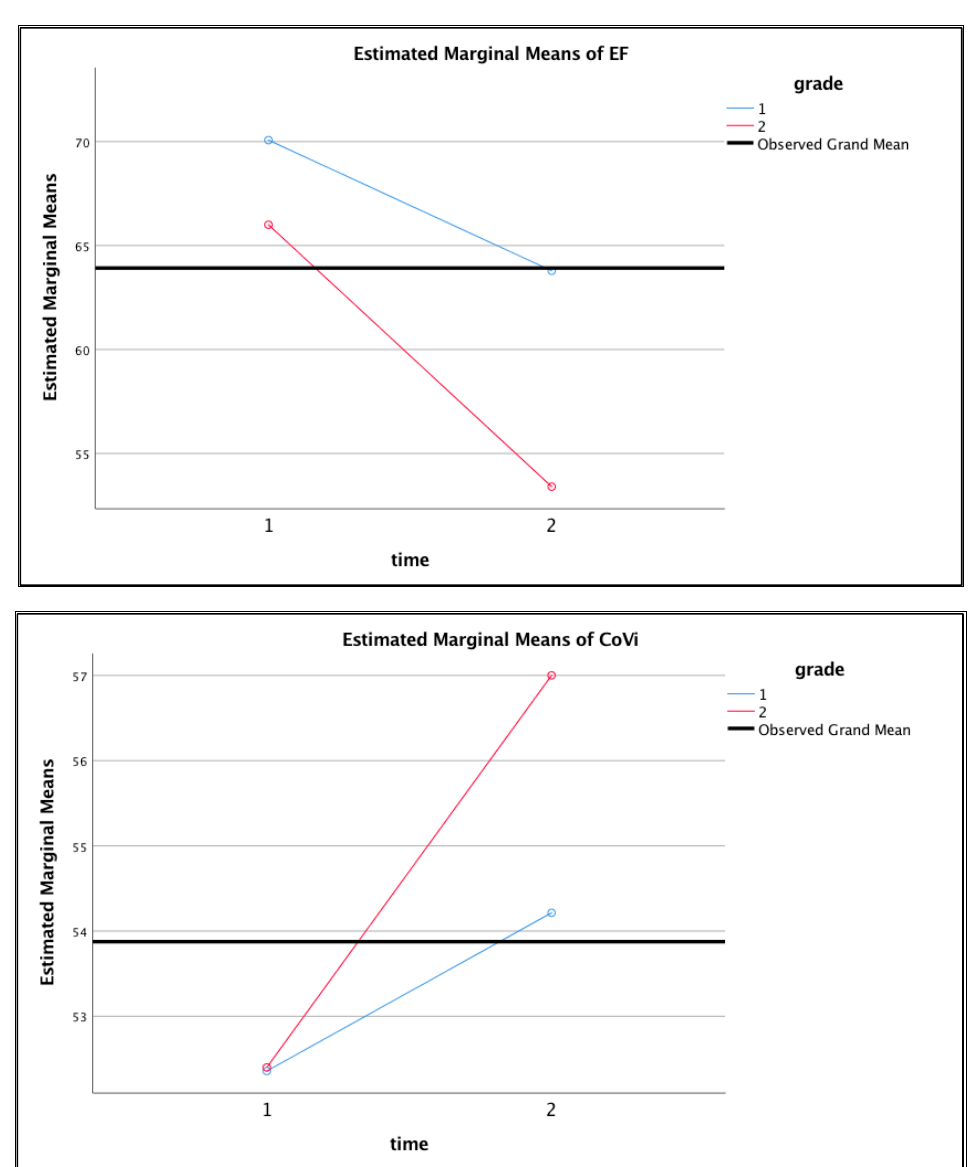
Figure 1. Profile Plots of Estimated Marginal Means. Grade 1 = waitlist control group; Grade 2 = intervention group; EF = executive functioning; CoVi = covitality; Lower ratings on the BRIEF-2 represent higher EF; Higher ratings on the SEHS-P represent higher CoVi.